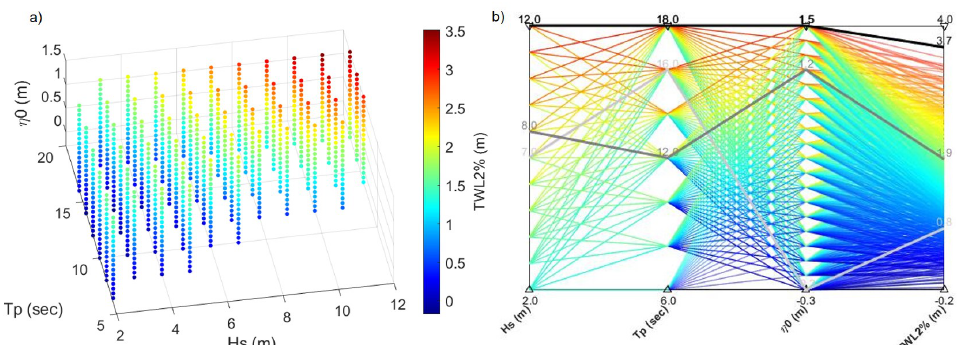
Figure 5. Entire set of modeling scenarios (triplet H s , T p , η 0) and results for reference coral reef and upperbeach vegetation configuration. Three-dimensional scatter ( a ) and parallel ( b ) plots with input variables H s , T p , and η 0, and output variable TWL 2% . The color scale is the same on both graphs. Four random paths on ( b ) are highlighted (black